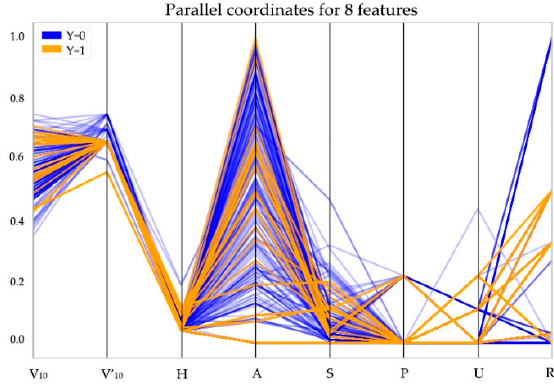
Figure 4. Parallel coordinates for eight features.